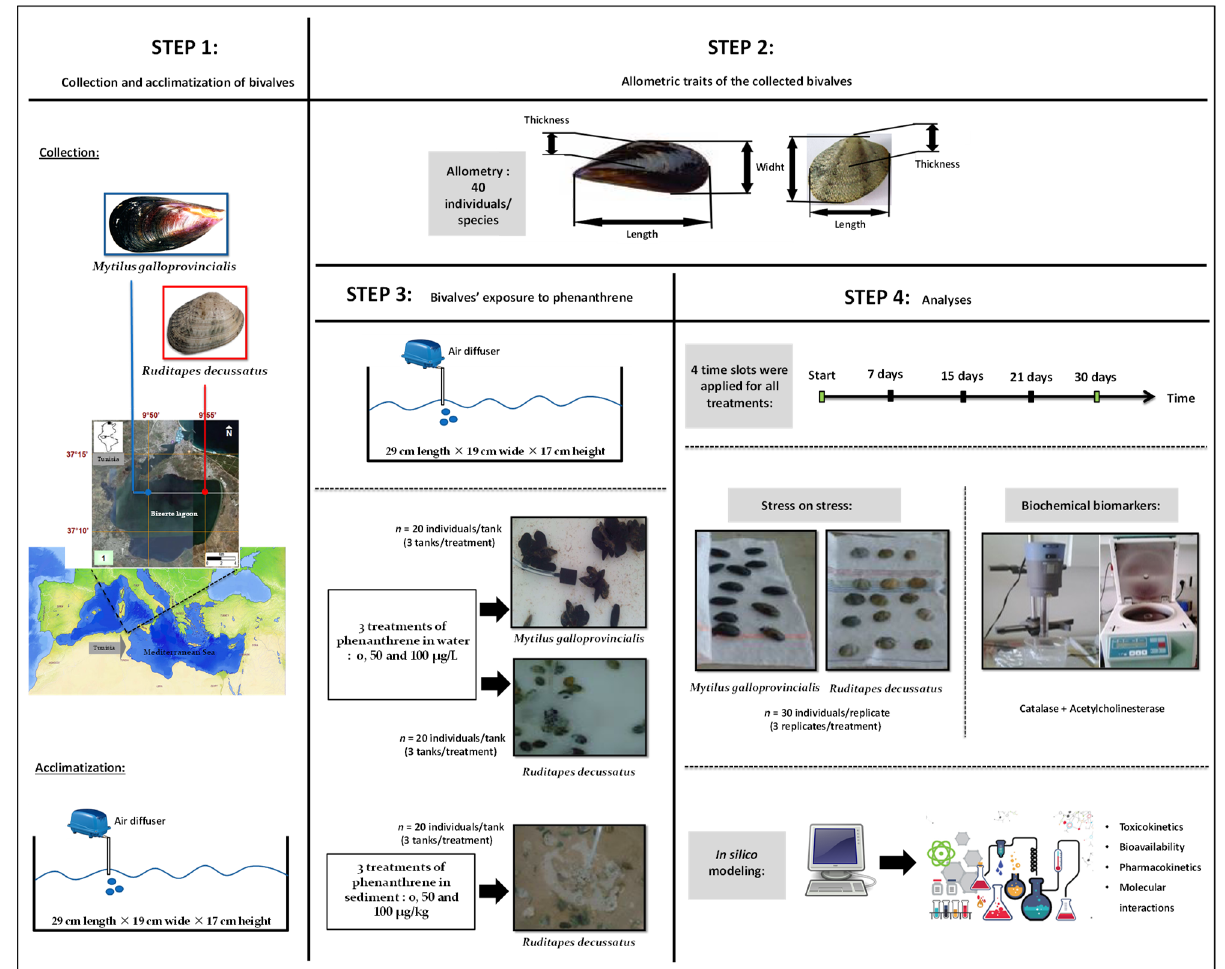
Figure 1. Graphical summary of steps and methodology